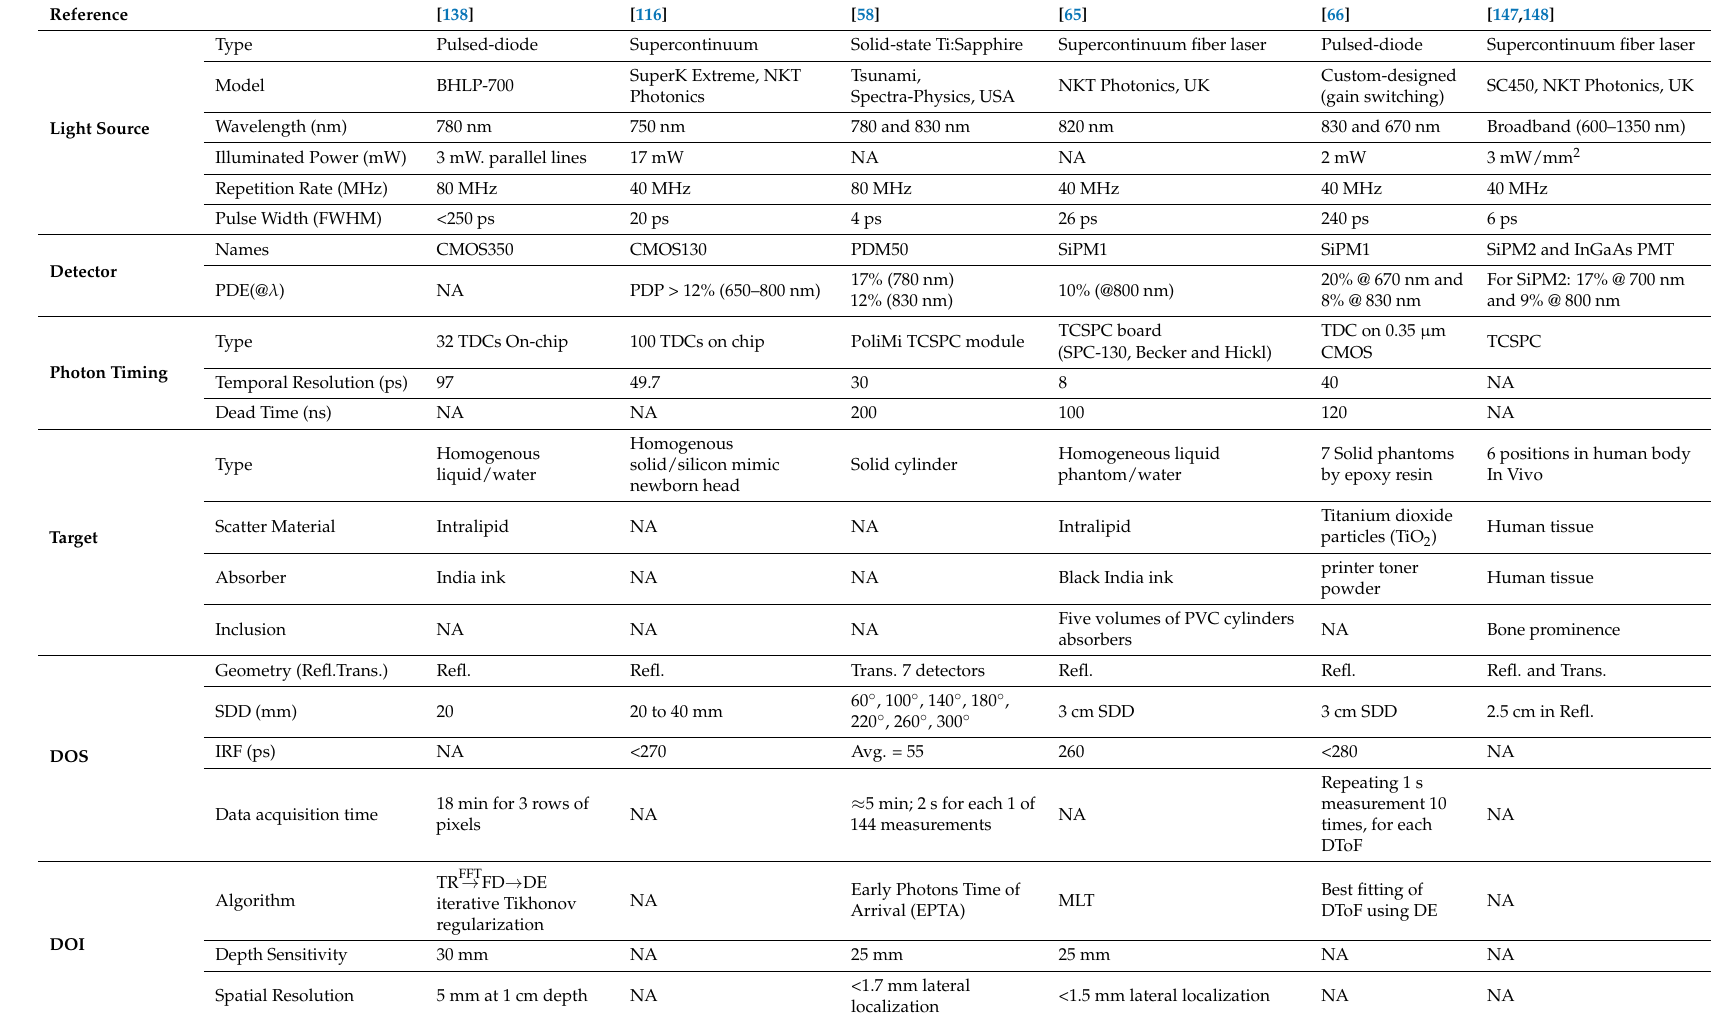
Table 2. Components, main features, and performance of FR TR-DOI